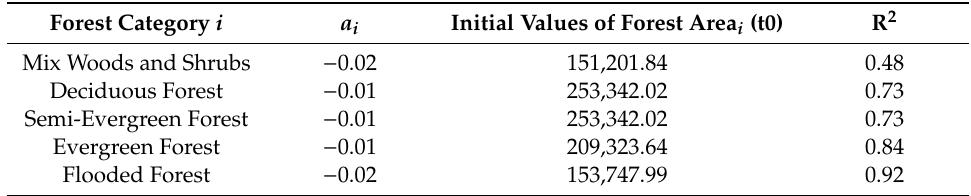
Table 4. Forest land cover change rate by category from the regression